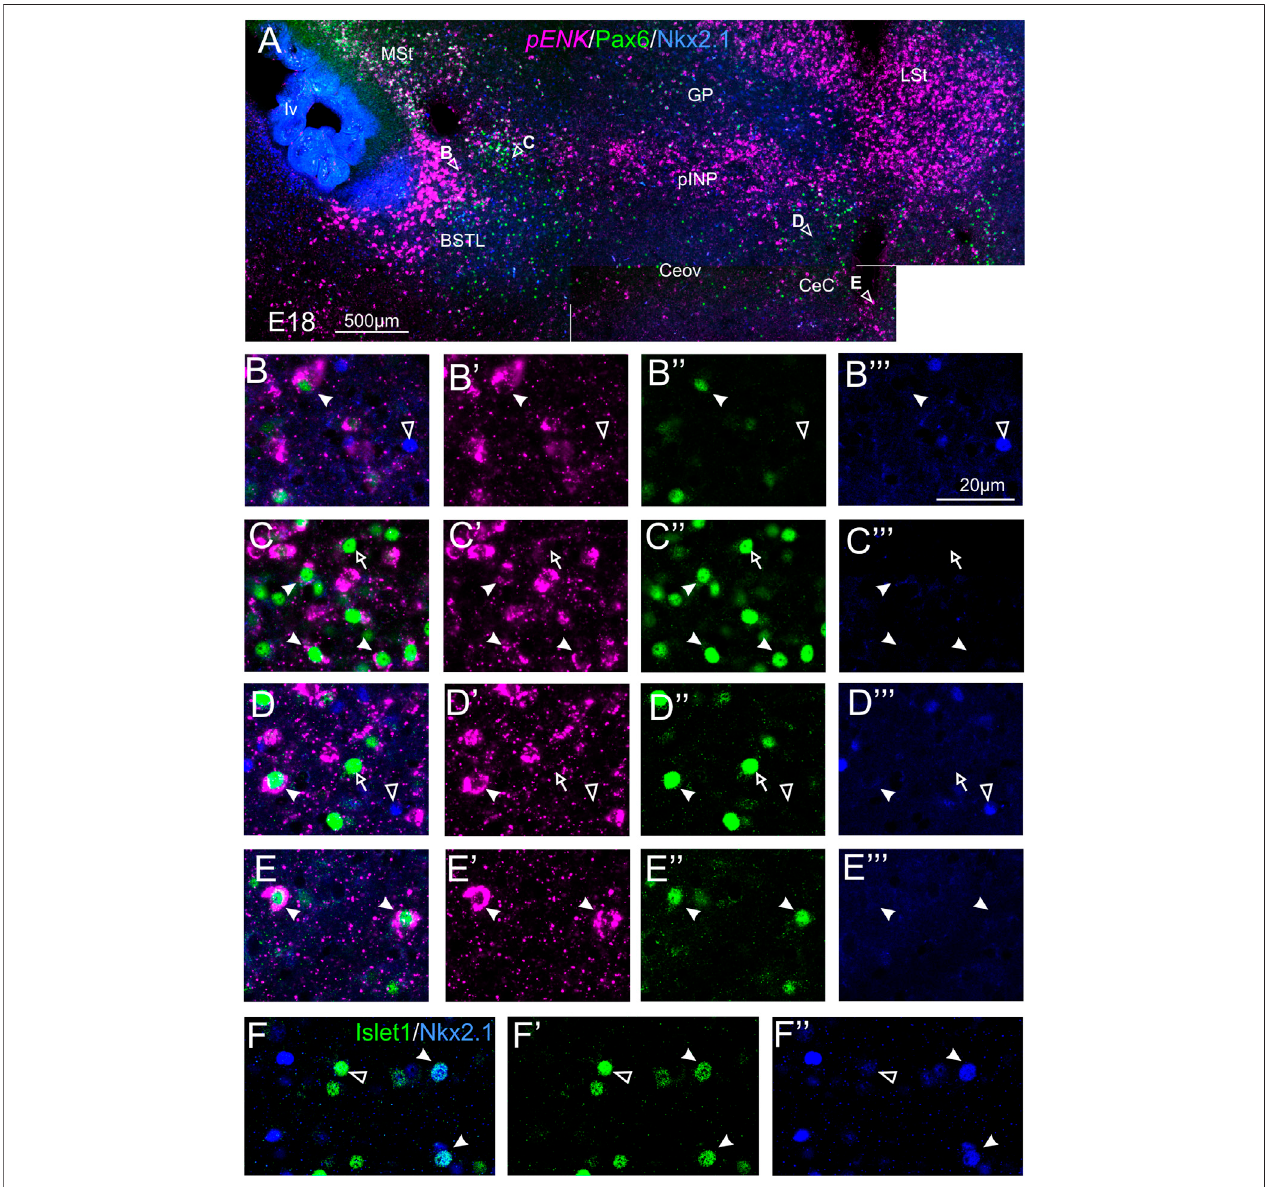
FIGURE 5 | Triple and double fl uorescence labeling of pro-ENK ( pENK ), Pax6 and Nkx2.1, or Islet1 and Nkx2.1 in the chicken central extended amygdala at E18. (A) General view (×10 objective) of the subpallium in frontal sections at the level of the anterior commissure, processed for indirect fl uorescent in situ hybridization for pENK (magenta),immuno fl uorescenceforPax6(green),andimmuno fl uorescenceforNkx2.1(blue).Details(×40objective,onlyonesinglezleveloftheconfocalstack)of the areas pointed with arrowheads in A are shown in (B – B - ) (for BSTL), (C – C - ) (for medial pINP), (D – D - ) (for lateral pINP, and (E – E 99 ) (for CeC) (merged plus separate magenta and green channels are shown). In these details, cells coexpressing pENK and Pax6 are pointed with a fi lled arrowhead, cells single labeled for Pax6 arepointedwithanemptyarrow,whilecellssinglelabeledforNkx2.1arepointedwithanemptyarrowhead(onlyafewexamplesarepointed).Nocoexpressionwasseen betweenPax6andNkx2.1. (F – F 99 ) :DetailsoftheBSTLwithdouble fl uorescenceofIslet1(green)andNkx2.1(blue).Mostcellsdidnotshowcoexpression(emptyarrow), but we found very few examples ( fi lled arrow). See text for more details. For abbreviations see list. Scale bars: (A) = 500 μ m; (B - ) = 20 μ m [applies to (B – B - ) to (F – F - )